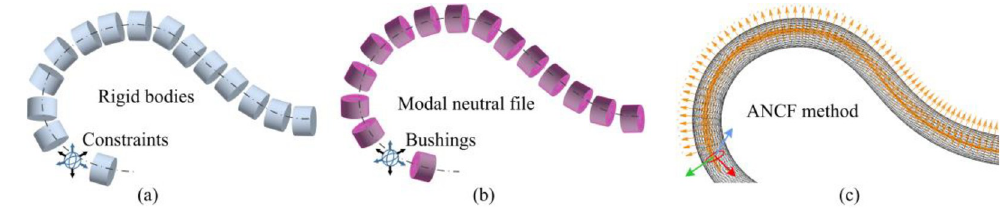
Fig 11. Schematic and Comparison of different methods about geometric